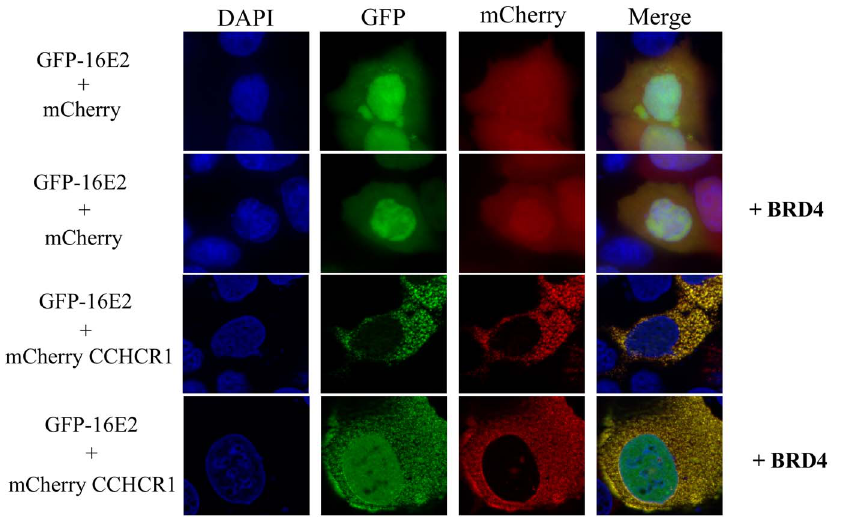
Figure 6. Intermediate pattern of HPV16 E2 distribution in the presence of CCHCR1 and BRD4. HaCaT cells were transfected with GFP- 16E2 and mCherry-CCHCR1, untagged BRD4 or both together. After fixation, the cells were subjected to fluorescence microscopy after counterstaining of the nucleus with DAPI. HPV16 E2 subcellular localization is not affected by the expression of BRD4. In presence of both CCHCR1 and BRD4, HPV16 E2 distributed both in the nucleus and in CCHCR1-containing cytoplasmic